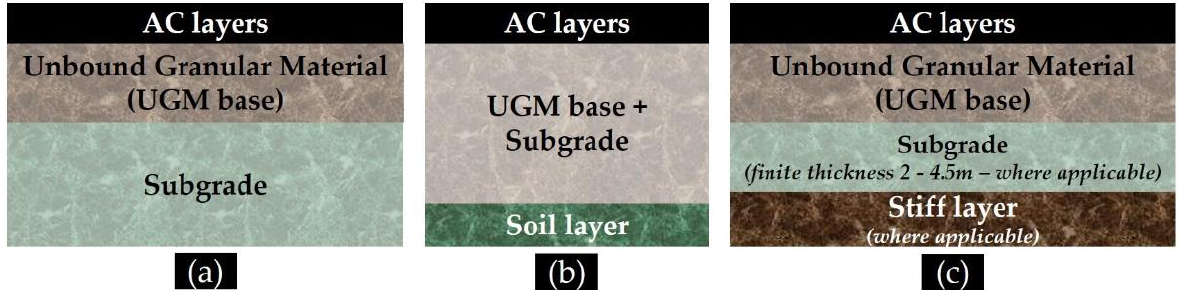
Figure 14. Pavement models for response analysis: ( a ) Model A: AC/UGM/SUBG (reference model), ( b ) Model B: AC/UGM + SUBG/SOIL, and ( c ) Model C: AC/UGM/SUBG/STIFF SOIL.